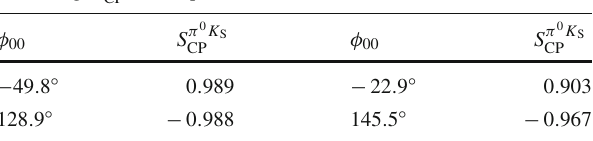
Table 5 The angles φ 00 and the corresponding mixing-induced CP asymmetries S π 0 K S